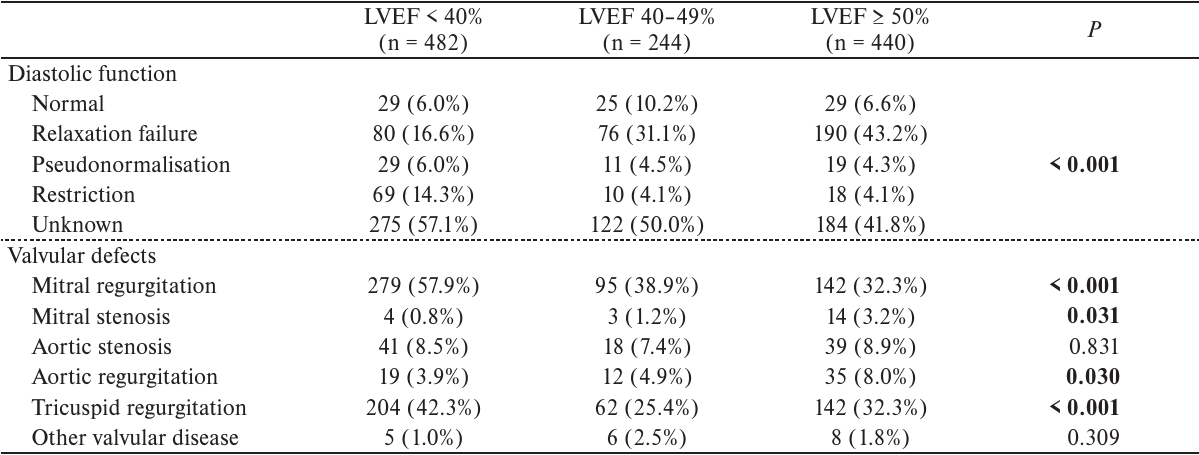
Table 4. Echocardiographical findings - diastolic function and valvular defects by LVEF groups. Only moderate-severe defects are reported.